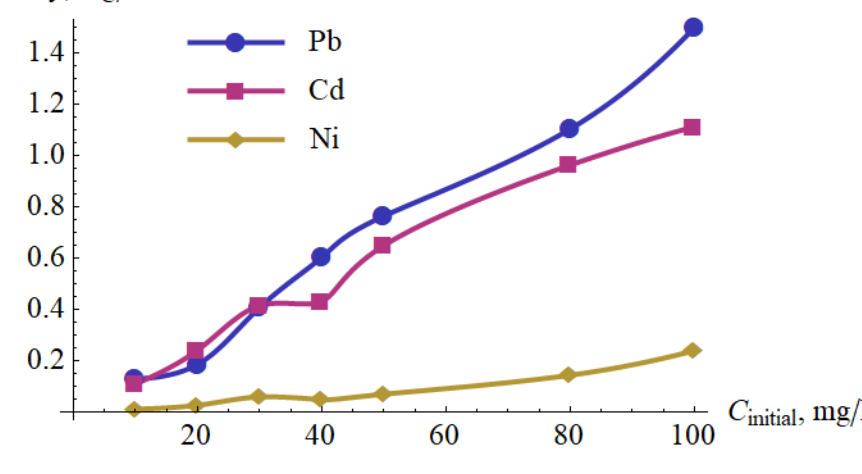
Figure 12. Energetical efficacy of removing metal ions.